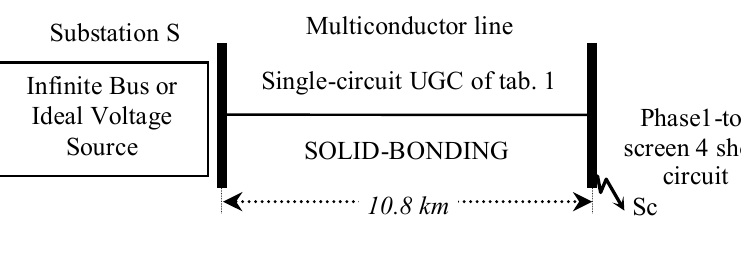
Figure 13. Faulted single-circuit UGC supplied at sending